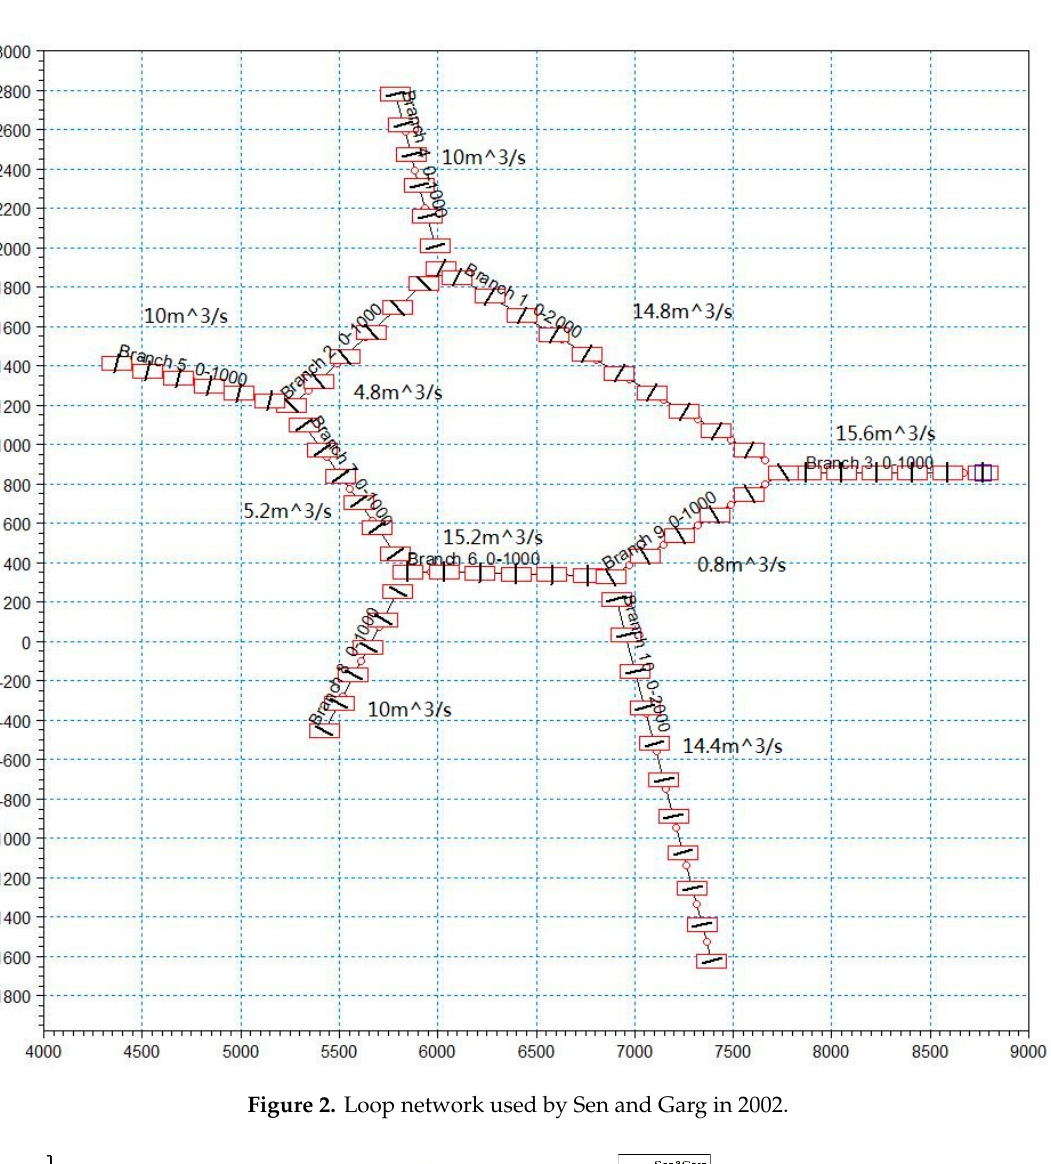
Figure 2. Loop network used by Sen and Garg in 2002.